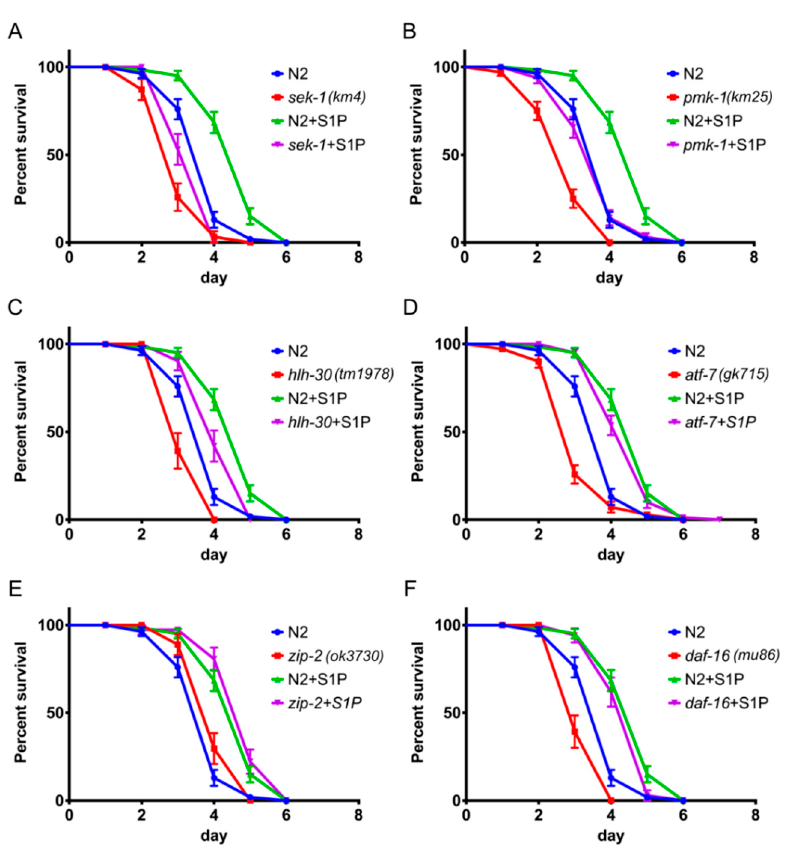
Figure 5. Increased immune response by S1P in C. elegans is dependent on p38 mitogen-activated protein kinase (MAPK) pathway and partially on hlh-30 . The survival of worms with or without S1P supplementation in the background of wild type N2 and p38 MAPK pathway, sek-1 and pmk-1 ( A , B ), transcription factors hlh-30 ( C ), atf-7 ( D ), zip-2 ( E ), and daf-16 ( F ). The log-rank (Mantel-Cox) test was used for statistical analysis of worm survival.